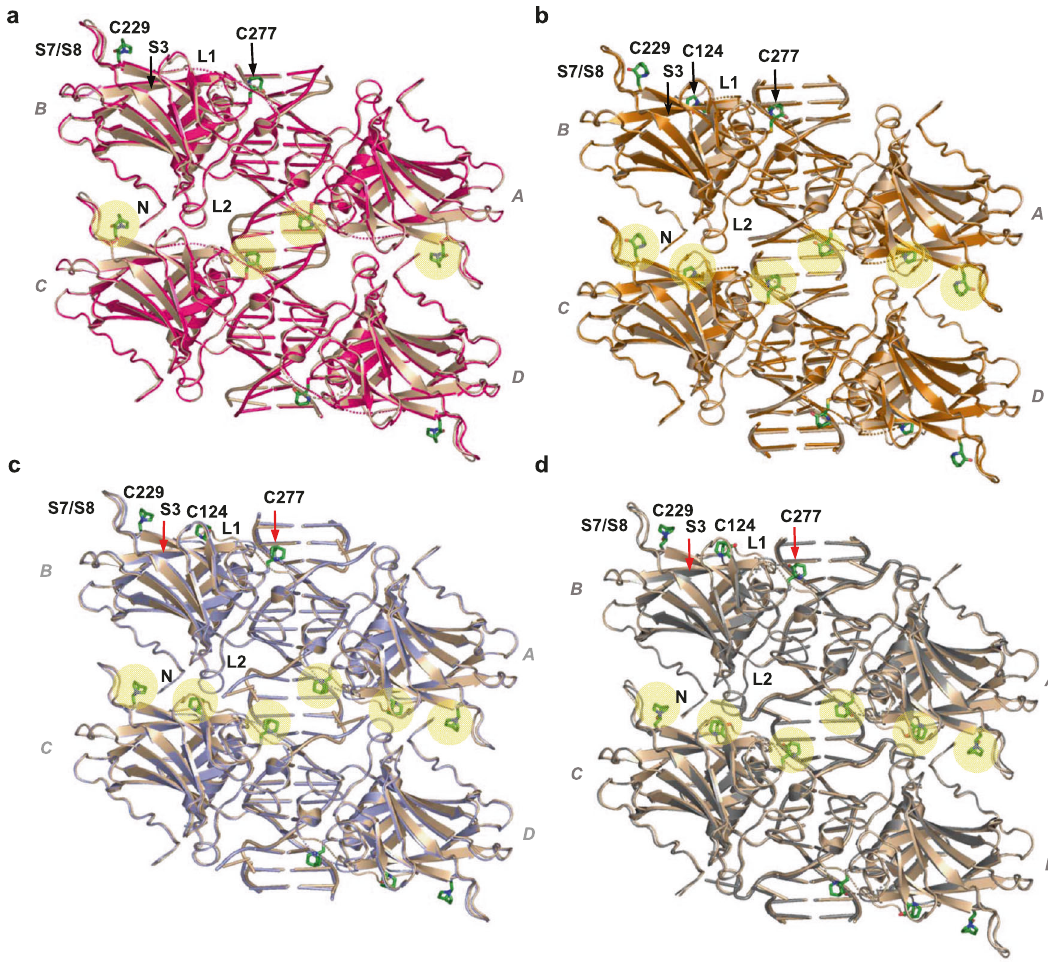
Fig. 6 MQ bound to C124, C229 and C277 in mutant and wild type p53-DNA tetramers. The structures of tetrameric p53-DNA-MQ complexes superposed on their MQ-free counterparts are the following. a R273H-DNA-MQ (magenta) and R237H-DNA (light brown). b R282W-DNA-MQ (copper) and R282W-DNA (light brown). c R273C/S240R-DNA-MQ (light blue) and R273C/S240R-DNA (PDB ID: 4IBV, light brown). d wt-DNA-MQ (I) (grey) and wt-DNA (PDB ID: 3IGL, light brown). The MQ-Cys conjugates are present in all four monomers due to crystal symmetry. The tetrameric p53-DNA structures are in cartoon representation. The MQ conjugates are in stick representation (green) and highlighted by yellow spheres at the horizontal region between the dimers ( AB and CD ). The MQ-modi fi ed Cys residues and adjacent protein regions (L1, L2, S7/S8, and S3) of each tetramer are labeled at the top left-handed p53 monomer. The presented DNA helices are made of 20 base pairs in ( a ), and 22 base pairs in ( b – d ) (the DNA constructs are shown in Supplementary Table 10). Close-up views of the MQ-Cys conjugates within the corresponding core domains are shown in Supplementary Fig.